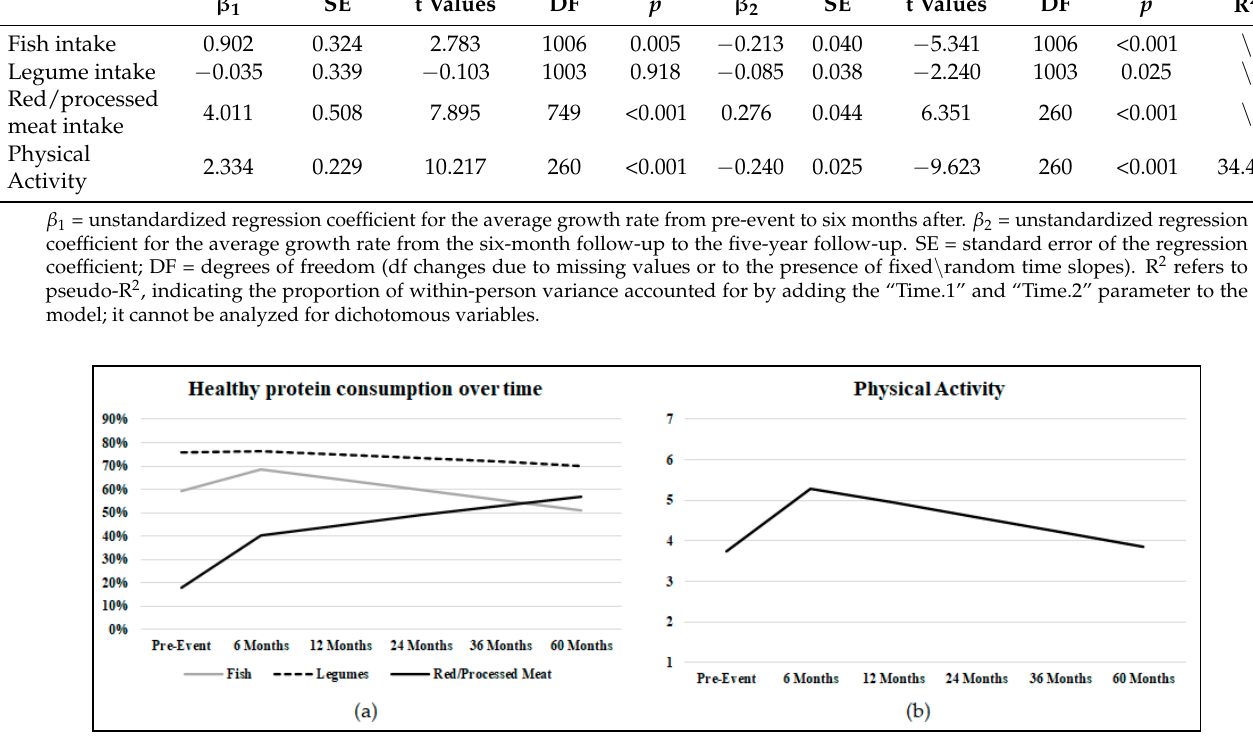
Figure 1. ( a ) The graph shows the longitudinal trajectory of healthy protein consumption (i.e., two or more portions of fish per week—grey line, two or more portions of legumes per week—dashed line, two or fewer portions of red meat per week/processed—black line). The time is represented on the horizontal axis, the percentage of patients showing healthy behavior is represented on the vertical axis; ( b ) the graph shows the longitudinal trajectory of the amount of physical activity. The time is represented on the horizontal axis; the average physical activity score is represented on the vertical axis. The total score ranges from 1 to 7, with higher scores indicating a healthier amount of physical activity. Scores higher than 6 indicate the target amount of physical activity for cardiovascular prevention.